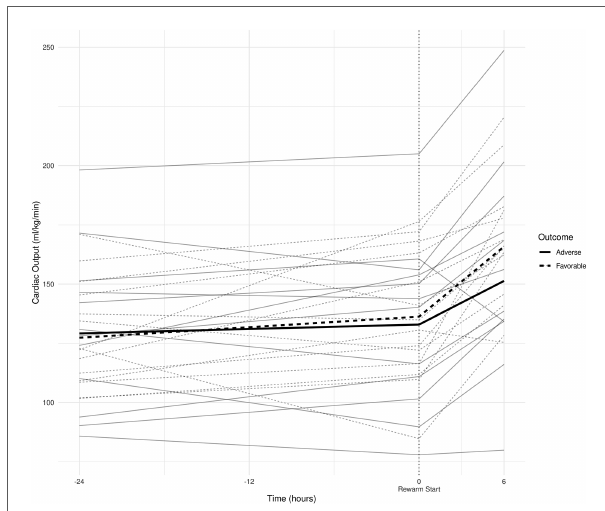
FIGURE 5 Estimated individual cardiac output regression lines and group-level averages of graphs.